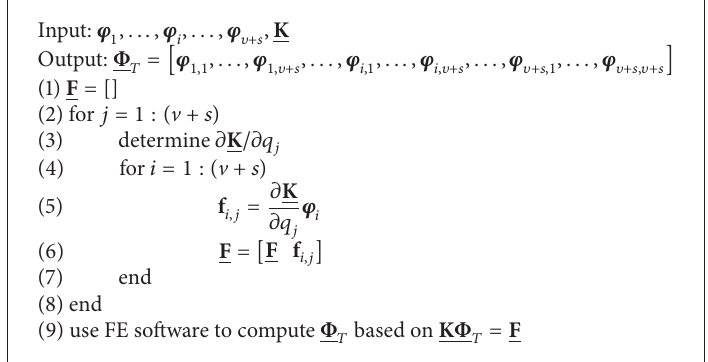
Algorithm 1: Computation of TVD for a given reduction base 𝜑 1 to 𝜑 𝑣+𝑠